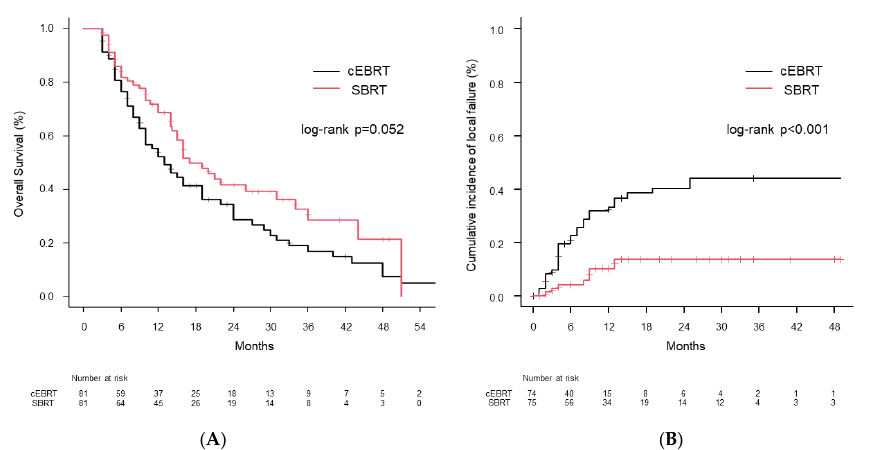
Figure 3. ( A ) Kaplan−Meier curves of overall survival and ( B ) cumulative incidence of local failure after radiotherapy in the propensity score-matched cohort.